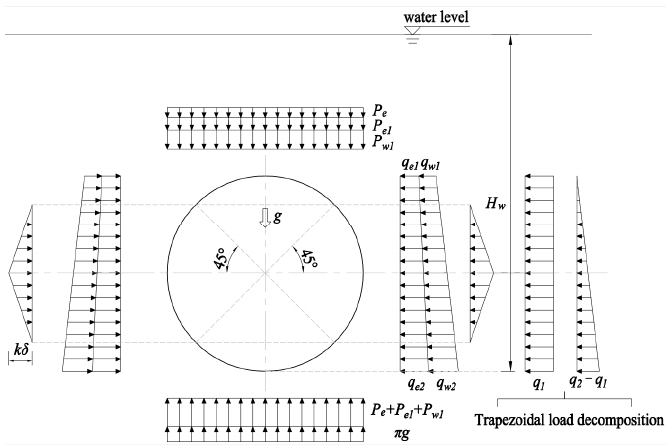
Figure 5. Load acting on segment with existing modified usual calculation method.